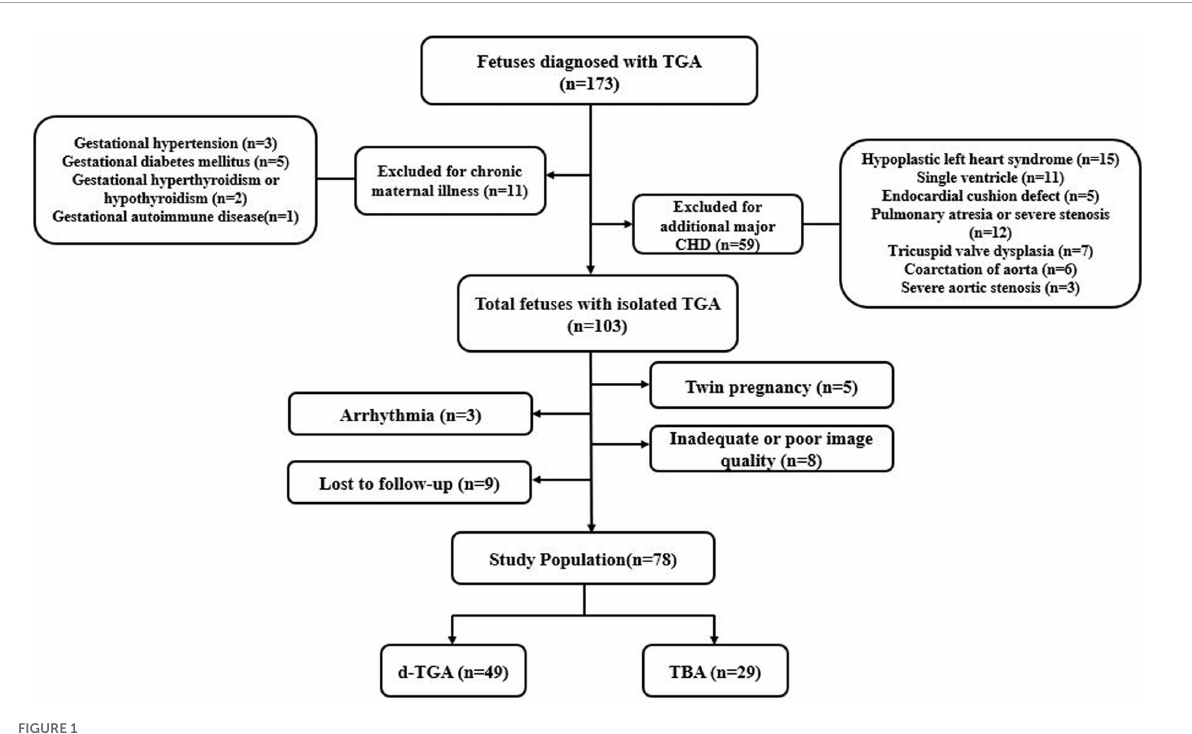
FIGURE1 Flowchart of patient inclusion and exclusion